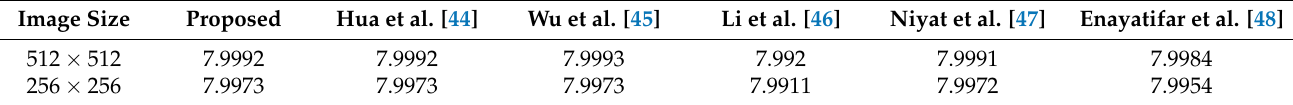
Table 3. Comparison of average entropy values between our algorithm and other encryption